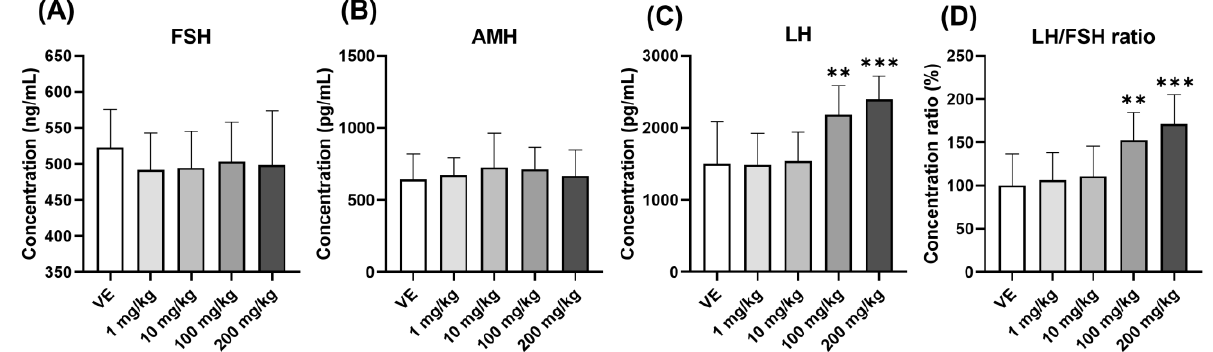
Figure 4. Changes in the concentration of the gonadotropin hormone and the anti-müllerian hormone in the serum. Confirmation of hormones in the serum of rats exposed to D5 for four weeks using ELSIA: ( A ) FSH concentration in serum; ( B ) AMH concentration in serum; ( C ) LH concentration in serum; ( D ) concentration ratio of LH and FSH in serum. The values are expressed as means ± SD. ** p < 0.01 and *** p < 0.001 vs. vehicle. VE—vehicle, N = 9~10.